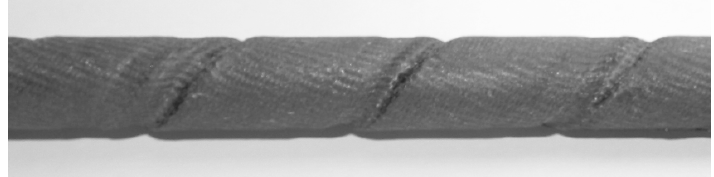
Figure 2. Rebar surface. Table 2. Mechanical properties of CFRP rebars according to catalogue.